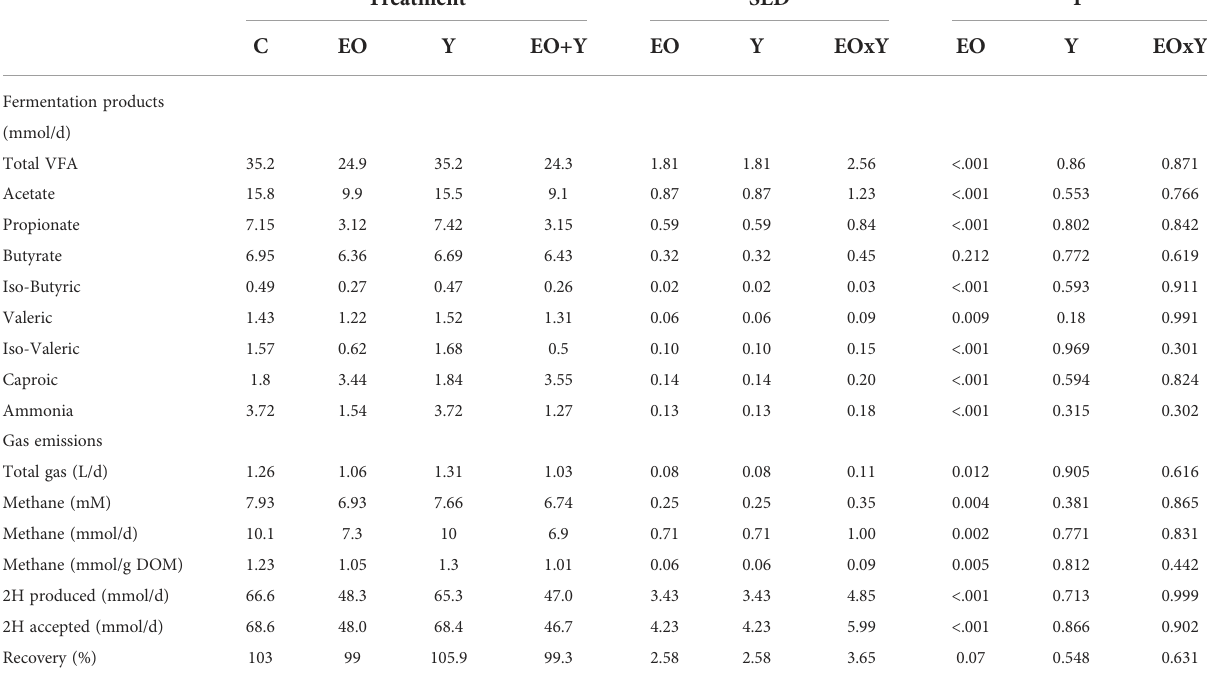
TABLE 2 Effect of supplementing a control diet (C) with oregano oil (EO), yeast (Y) or a combination of both (EO+Y) on fermentation products and methanogenesis in the RUSITEC system. Treatment